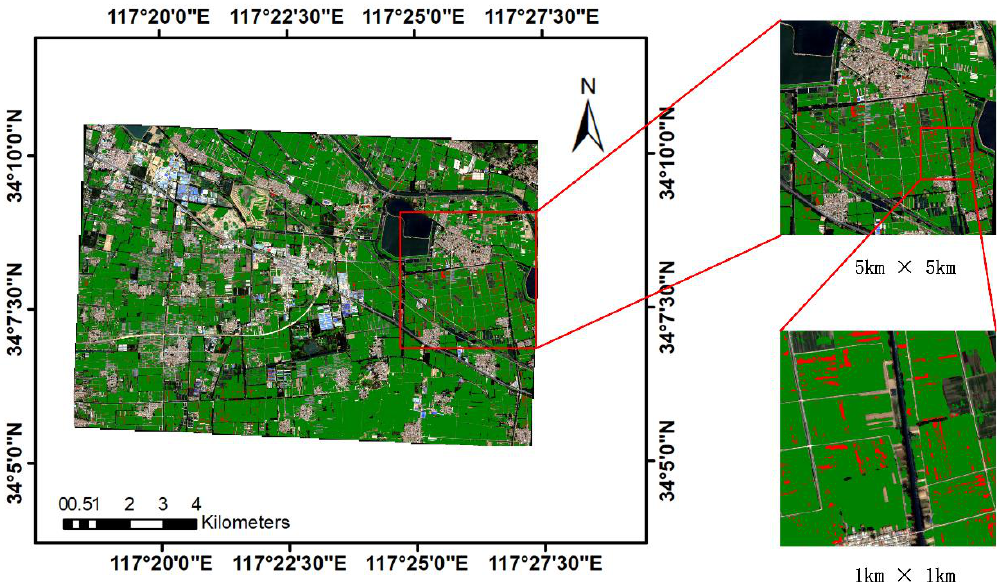
Figure 15. The distribution map of lodged and non-lodged wheat in the southern area of Zhangji Town.